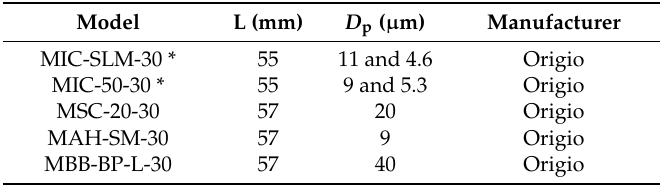
Table 1. Micropipettes used in the generation of microbubbles.